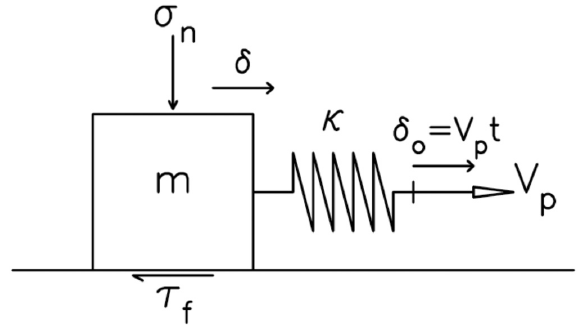
Figure 2. A one-body dynamical spring-slider model: m, mass of the slider; v , normal stress; V , driving velocity; x , frictional stress; l , n p f , slip of the loading spring constant; d , slip of the slider; and d o